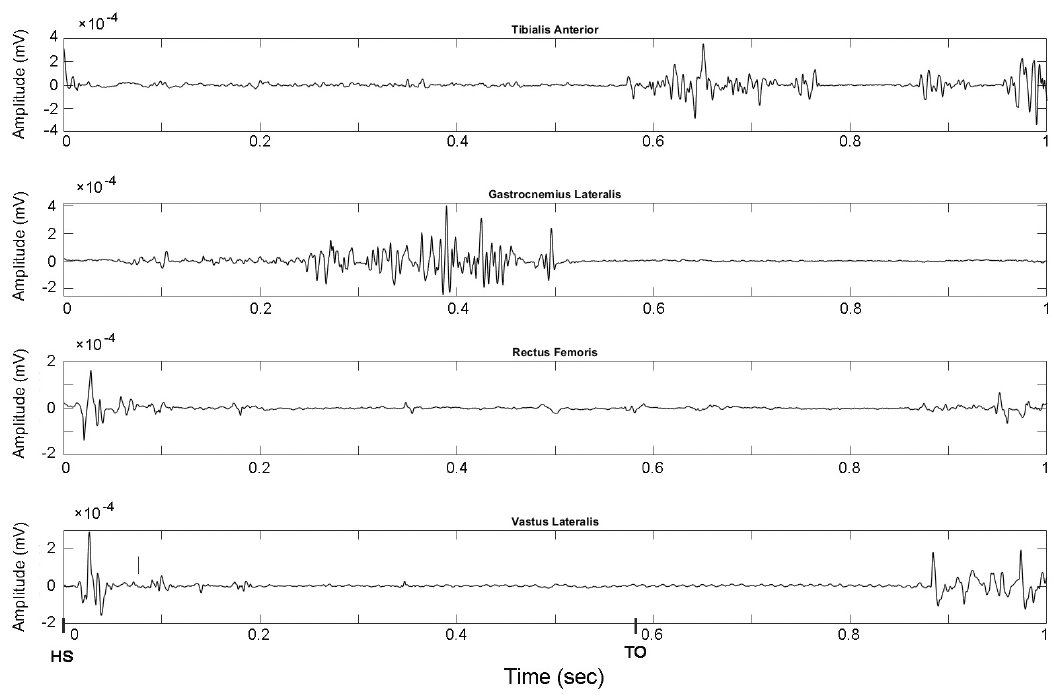
Figure 2. Raw electromyographic (EMG) signals recorded from the four muscles of the right leg. Corresponding heel-strike (HS) and toe-off (TO) timing are highlighted.